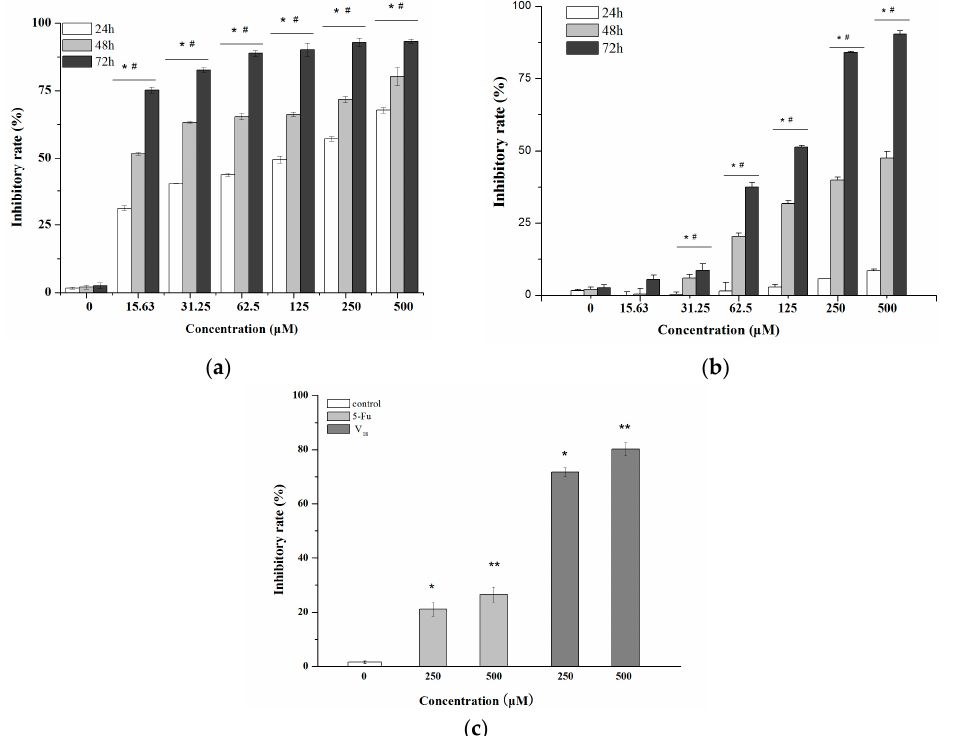
Figure 1. Inhibitory effect of V 18 with different concentrations on ( a ) MCF-7 cells and ( b ) MDA-MB-231 cells for 24 h, 48 h and 72 h. * p < 0.05 for V 18 at different time and doses compared to 0 µ M group. # p < 0.05 for V 18 in the same dose at different times. ( c ) Inhibitory effects of V 18 and 5-fluorouracil (5-Fu) on MCF-7 cells with the concentration of 250, 500 μ M at 48 h. * p < 0.05 for V 18 and 5-Fu at 250 μ M compared to 0 μ M group. ** p < 0.05 for V 18 and 5-Fu at 500 μ M compared to 0 μ M group.